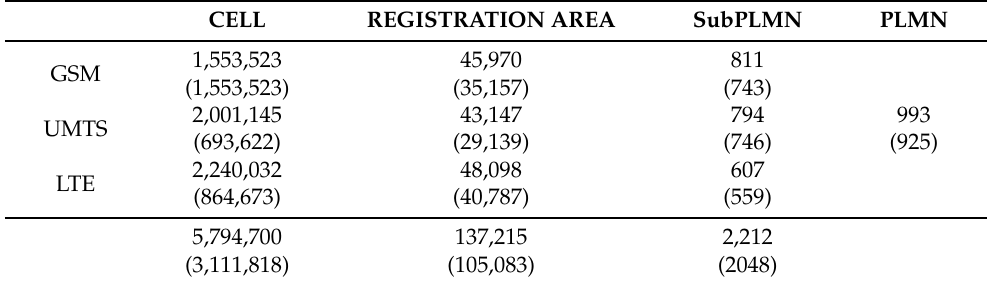
Table 4. Overall network summary: total number of elements in our database (polygons in